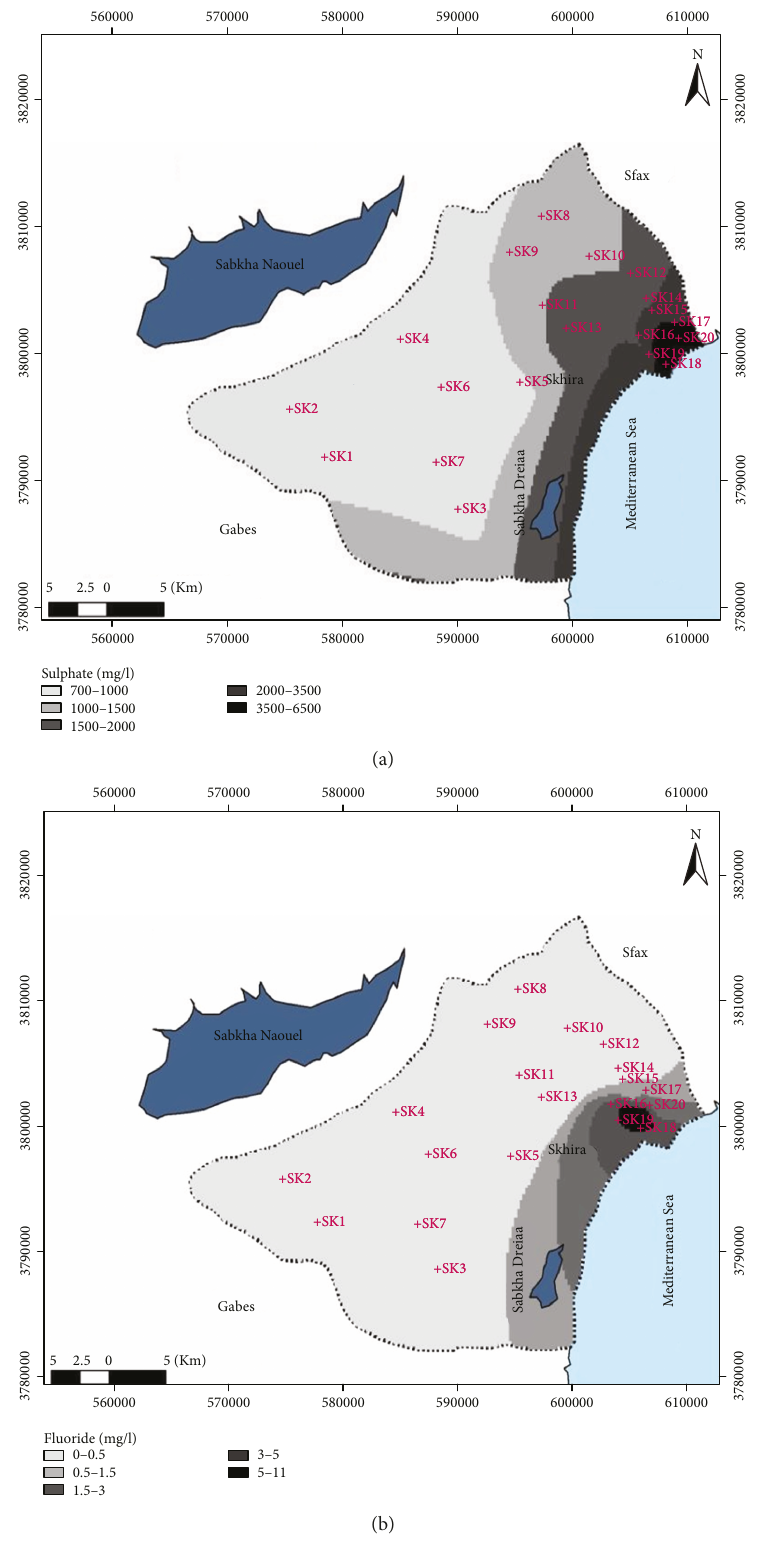
Figure 5: Spatial distribution maps of sulphate (a) and fl uoride (b) in groundwaters of the Skhira aquifer. See mean error (ME) and root mean square error (RMSE) in Table